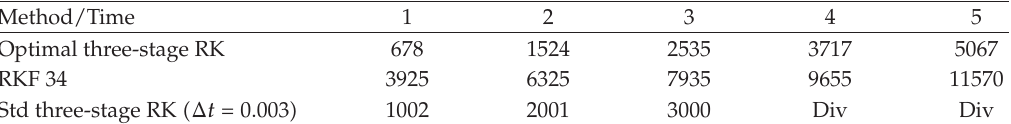
Table 2: Comparison for number of iterations among the optimal three-stage RK, RKF 34, and standard three-stage RK. The optimal three-stage RK method is counted three times for the function evaluation per iteration, while the RKF 34 is five times per